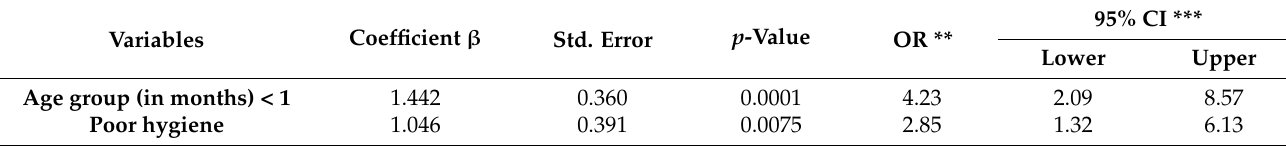
Table 2. Multivariate stepwise logistic regression analysis * of risk factors for Cryptosporidium infection that were significant using univariate analysis.